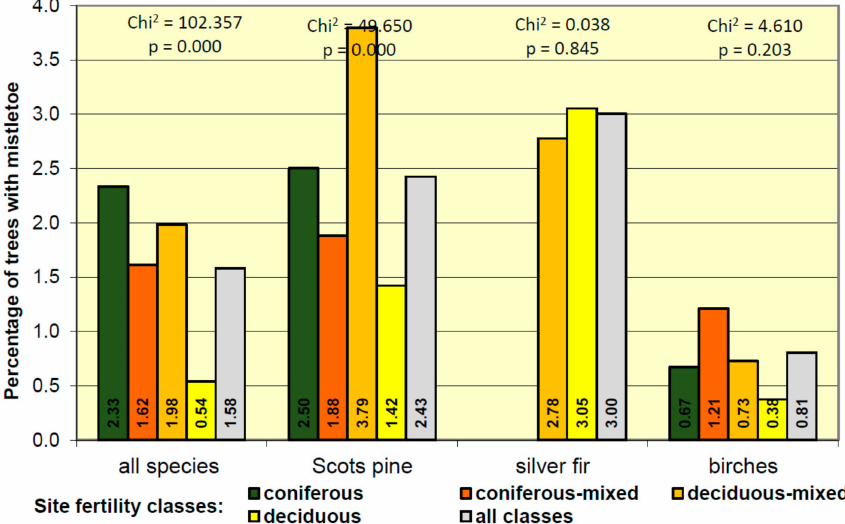
Figure 5. Percentage of trees with injuries caused by mistletoe in relation to fertility of sites, where the plots were located, and the results of the χ i 2 test for independence for all trees together (all species) and separately for species most infested by mistletoe (Scots pine, silver fir and birches).